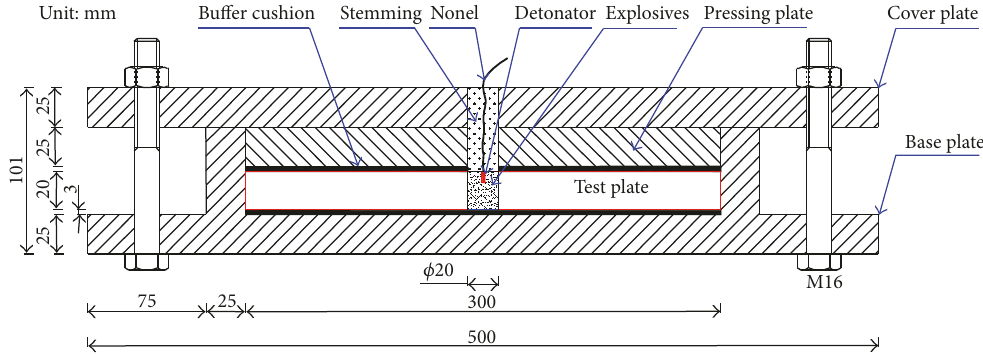
Figure 4: Schematic of the physical model.